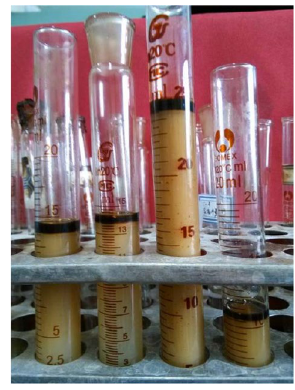
Fig. 17 Produced fluid is